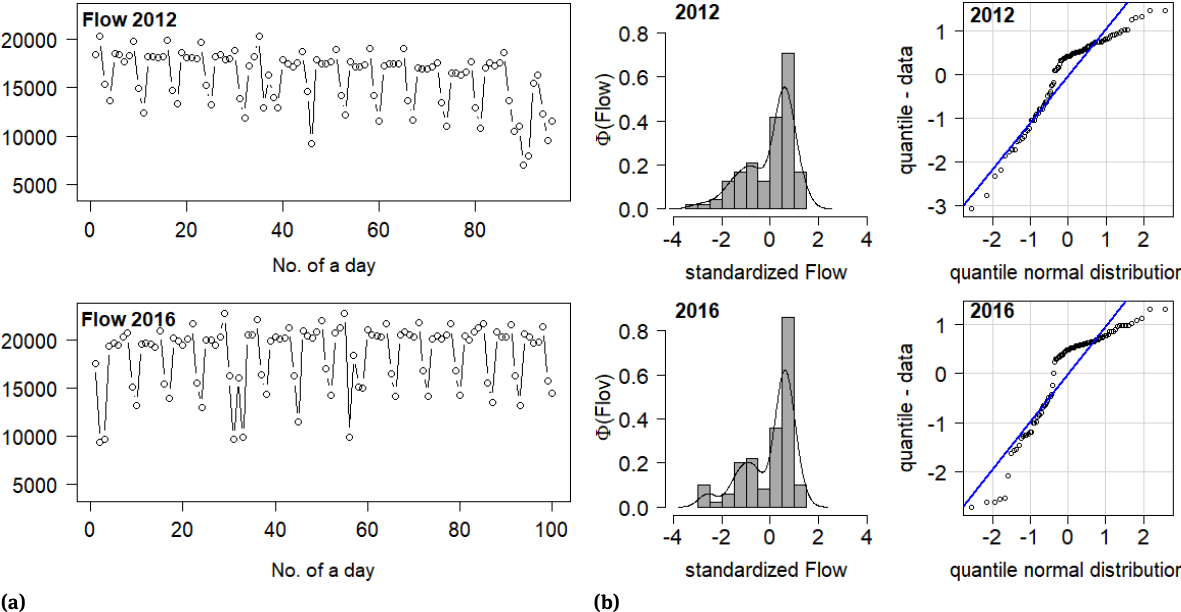
Figure 2: Day to day traflc flow in 2012 and 2016, as well as their probability distribution and Q-Q quantile charts a) in 2012 (from 27.09. to